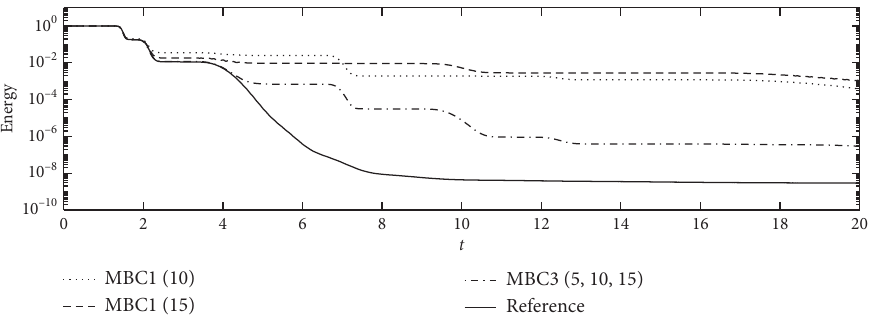
Figure 11: Energy of the wave packet with three major wave numbers k � 5, 10, and 15.